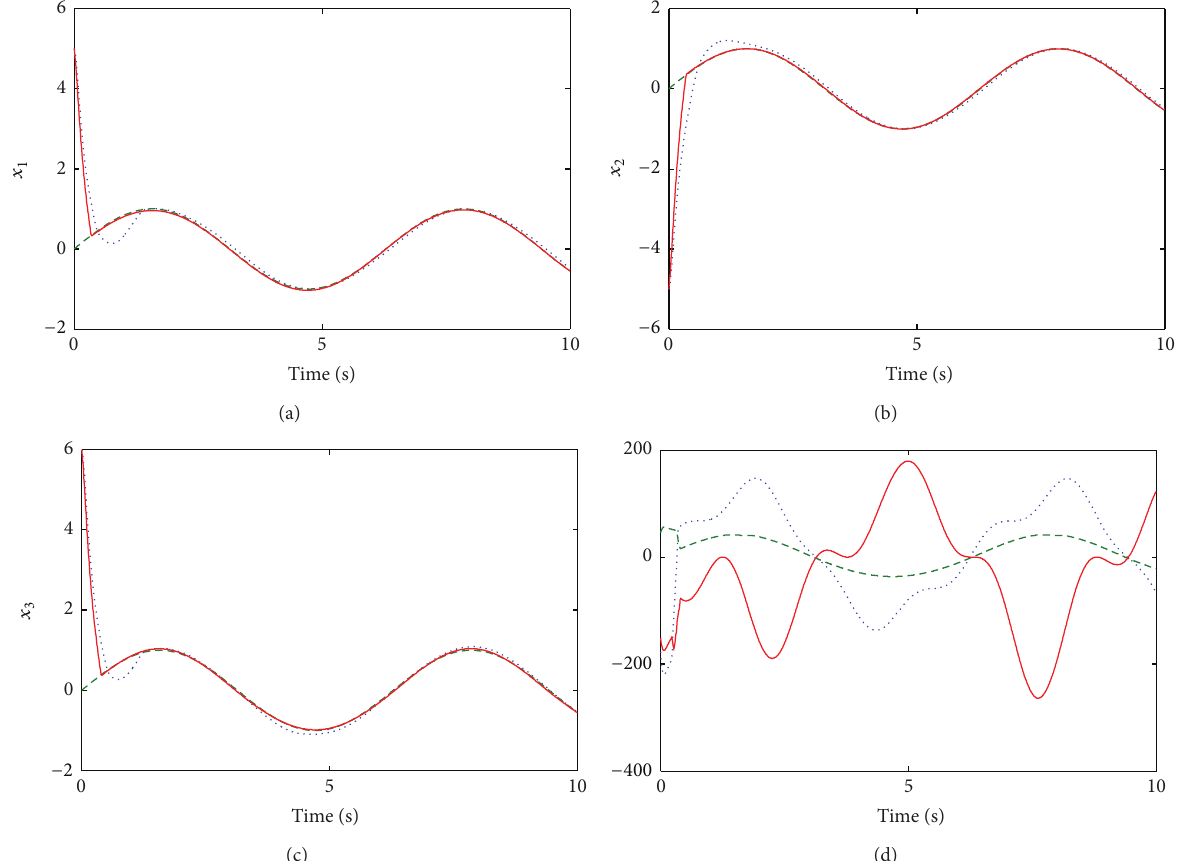
Figure 6: Comparison between our control method and the control method proposed in [12]. (a), (b), (c) Tracking of 𝑥 1 , 𝑥 2 , and 𝑥 3 : control method proposed in [12] (dotted line), desired curve (dashed line), and our control method (solid line). (d) The control inputs: 𝑢 1 (dotted line), 𝑢 2 (dashed line), and 𝑢 3 (solid